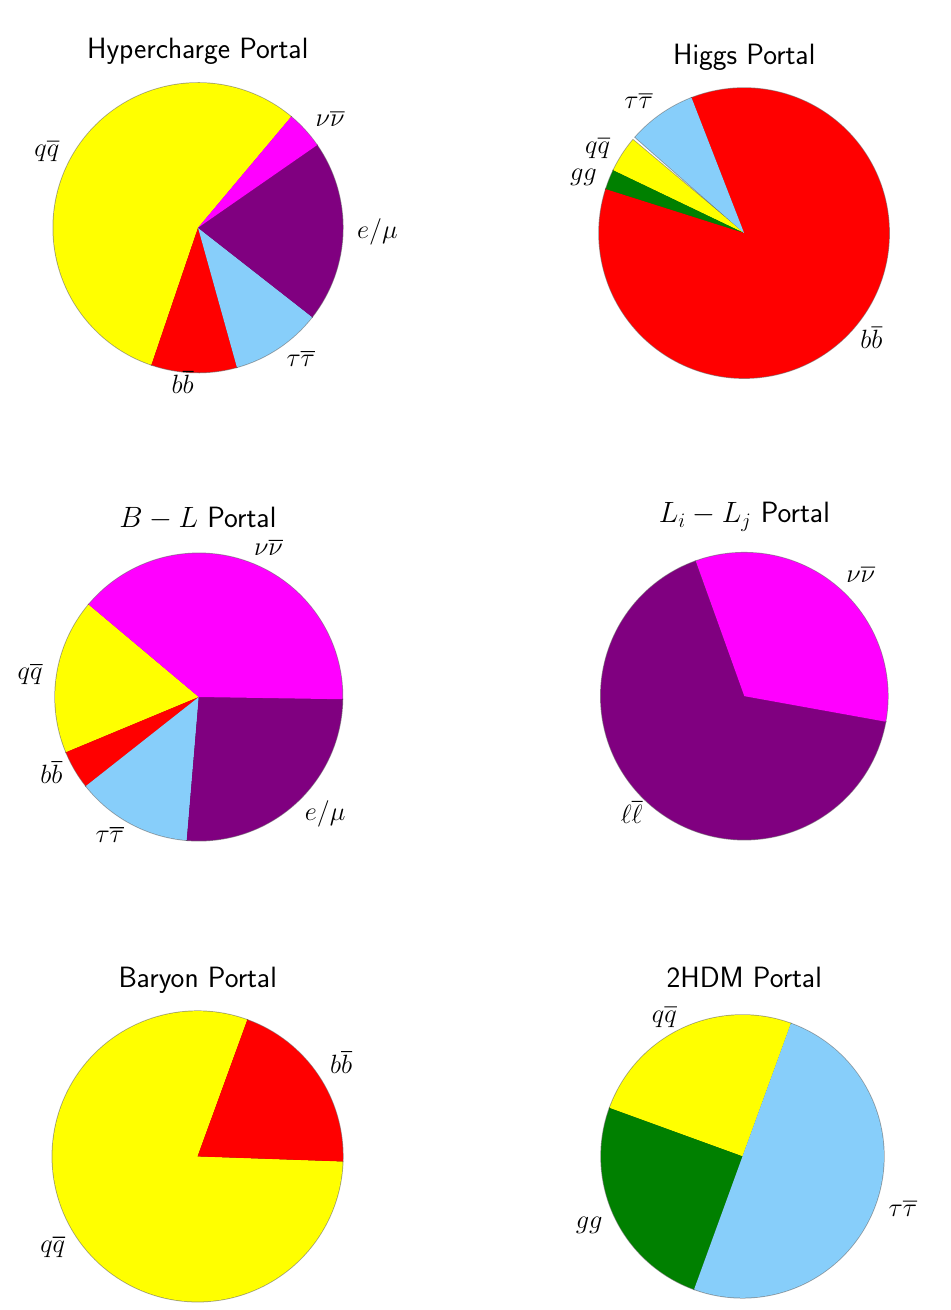
Figure 1 . Branching fractions of hidden sector particles decaying through various portal interac- tions. In each case, we have adopted a mass of 50 GeV for the decaying particle. In the case of the two-Higgs doublet model, we show results for a Type-II model with tan (cid:12) = 1, sin (cid:11) = 0. Note that q (cid:22) q in this (cid:12)gure denotes any of the four lightest quark species ( u , d , s , c ).